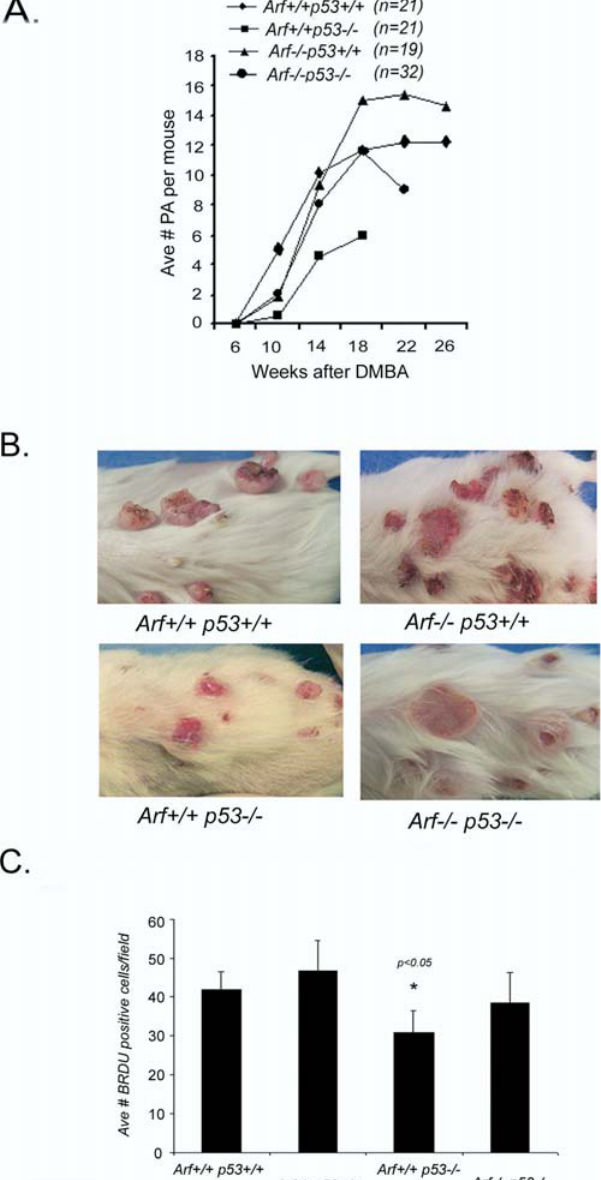
Figure 5. Tumor Multiplicity and Proliferative Index in p19 Arf /p53 Compound Mutant Mice (A) Average number of papillomas (more than 2 mm in diameter) per mouse is plotted against the number of weeks post-initiation. (B) Image of wild-type, p19 Arf (Arf) (cid:1) / (cid:1) , p53 (cid:1) / (cid:1) , and p19 Arf (cid:1) / (cid:1) p53 (cid:1) / (cid:1) mice with skin tumors at time of sacrifice. Wild-type mice show